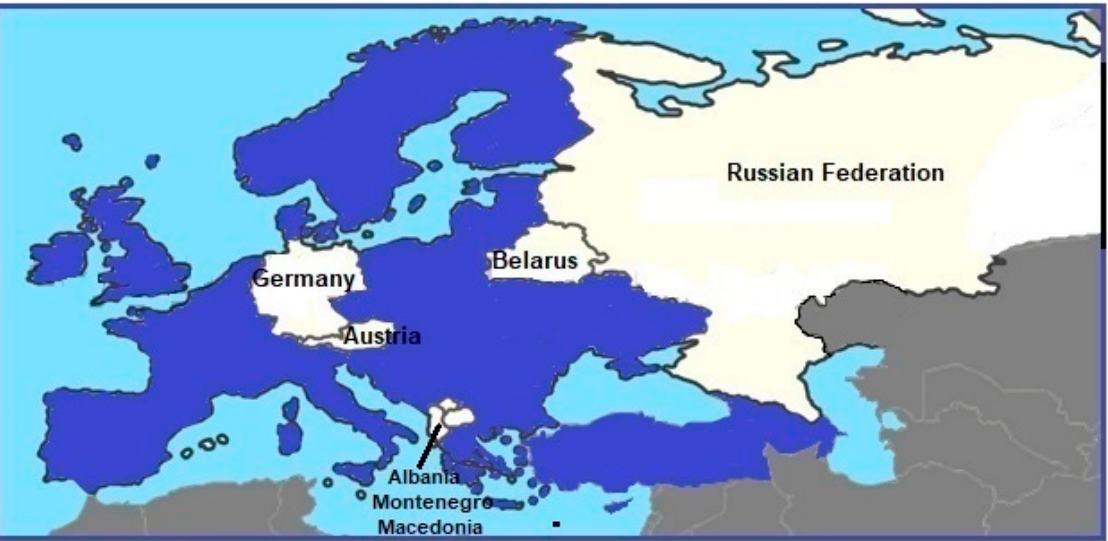
Figure 8. Ratification of the European Landscape Convention (Areas in blue have ratified the Euro- pean Landscape Convention.). European Landscape